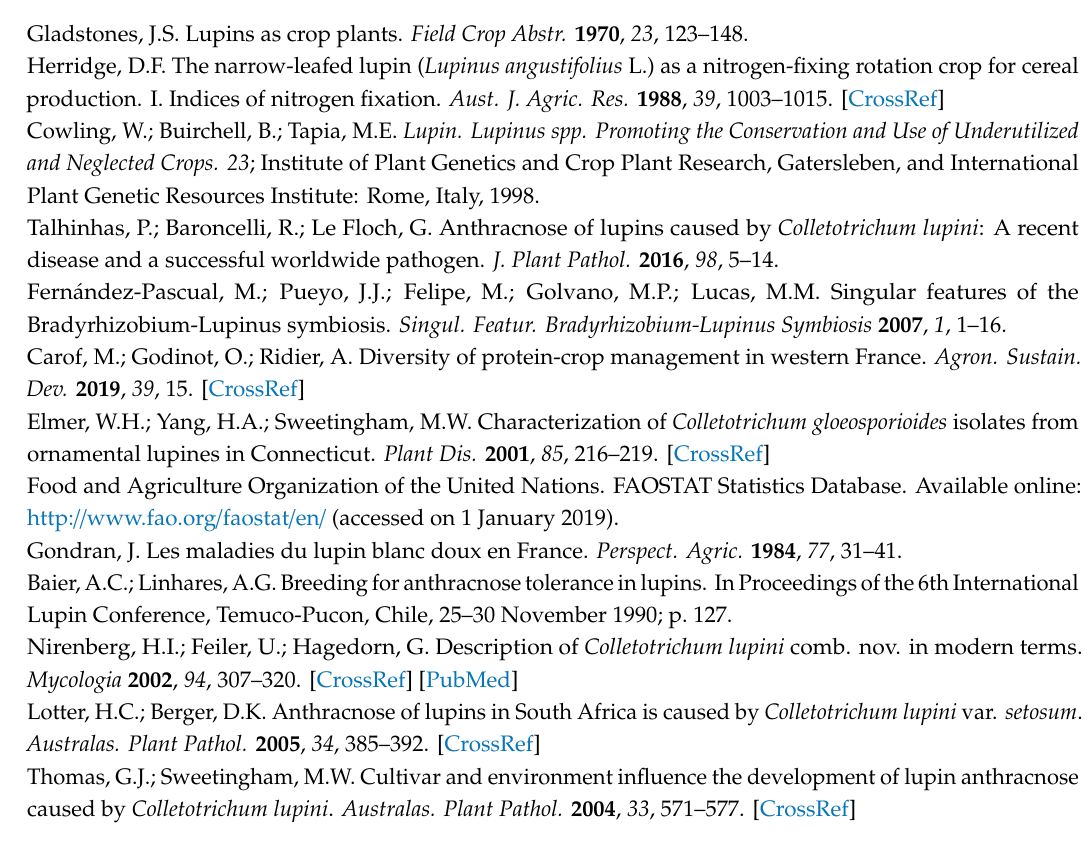
Figure S1: Influence of PDA osmotically modified with mannitol on seed germination of L. albus cv. Multitalia, L. luteus cv. Mister and L. angustifolius cv. Tango. − 0.3 MPa = PDA alone; − 0.8 MPa = PDA amended with 33.10 g L − 1 mannitol; − 1.0 MPa = PDA amended with 47.75 g L − 1 mannitol; and − 1.2 MPa = PDA amended with 62.46 g L − 1 mannitol. The red rectangle indicates the osmotic potential and the time chosen for the artificial inoculations of lupin seeds. Figure S2: Specific 736 bp IGS region flanked by the primer pair CLR / CLF. The sequences of C. lupini RB221 (IMI504893) and RB173 (CBS109225) were used as references. Some isolates of C. acutatum species complex belonging to clades 1 and 2 were compared and used to design the specific primer pair. Figure S3: Sensitivity of PCR using the primer pair CLF / CLR for the detection of C. lupini . The assay was performed using 10-fold dilutions ranging between 10 ng and 100 fg of mycelial DNA of C. lupini isolate 70555 (Lanes 1-6). Lane 7 = Negative control (without DNA). Marker = 100 bp DNA ladder. Figure S4: Specificity of PCR with the primer pair CLF / CLR for detection of C. lupini in seed samples artificially infected (a = 1:10, b = 1:100, c = 1:1000). Lane 1–2 = L. albus cv. Multitalia, Lane 3–4 = L. luteus cv. Mister, Lane 5–6 = L. angustifolius cv. Tango, Lane 7 = positive control ( C. lupini IMI504893), Lane 8a = seed control (100 seeds of L. albus cv. Multitalia), Lane 8b = seed control (100 seeds of = L. angustifolius cv. Tango), Lane 8c = seed control (100 seeds of = L. luteus cv. Mister), Lane 9 = negative control (without DNA), and Lane M = 100 bp DNA ladder. Table S1: DNA concentrations and absorbance ratios